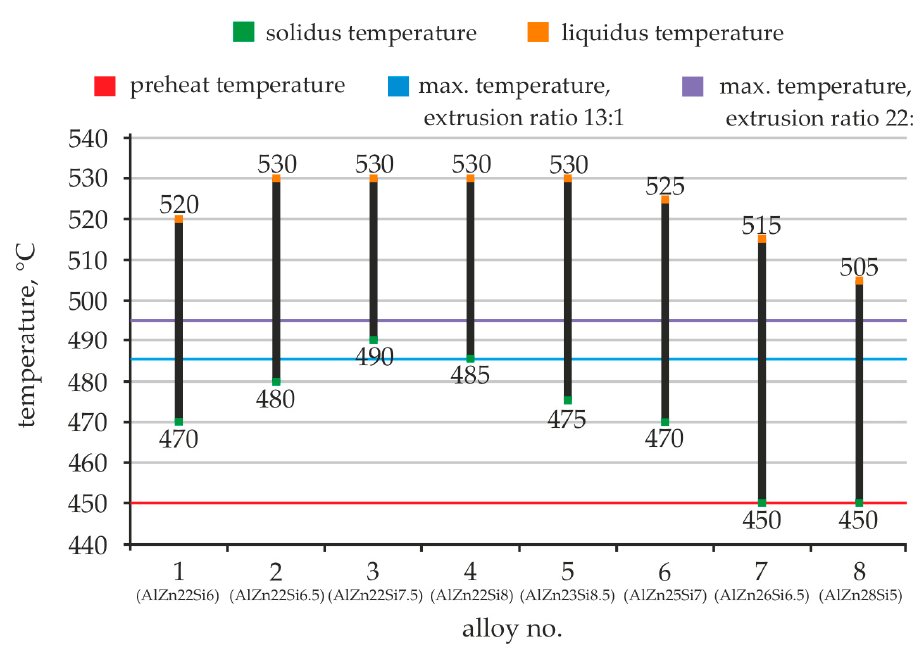
Figure 7. Determined melting intervals of the Al ‐ Zn ‐ Si alloys 1 to 8.